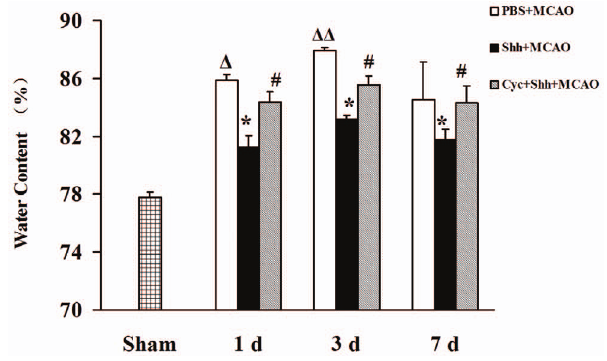
Figure 1. Shh Treatment Ameliorates the Brain Edema. After establishment of pMCAO, rats were intracerebroventricularly injected